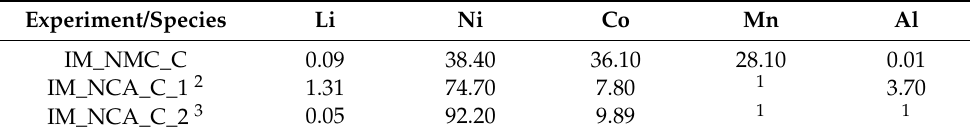
Table 4. Mass fractions of certain metals in the obtained metal phases. (w/%). Experiment/Species